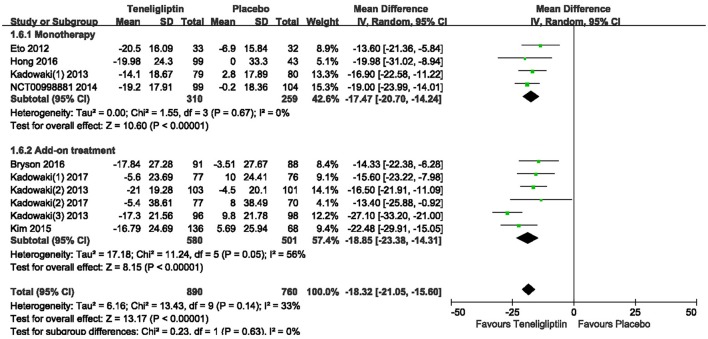
Effects of teneligliptin and placebo on FPG change from the baseline by meta-analysis.